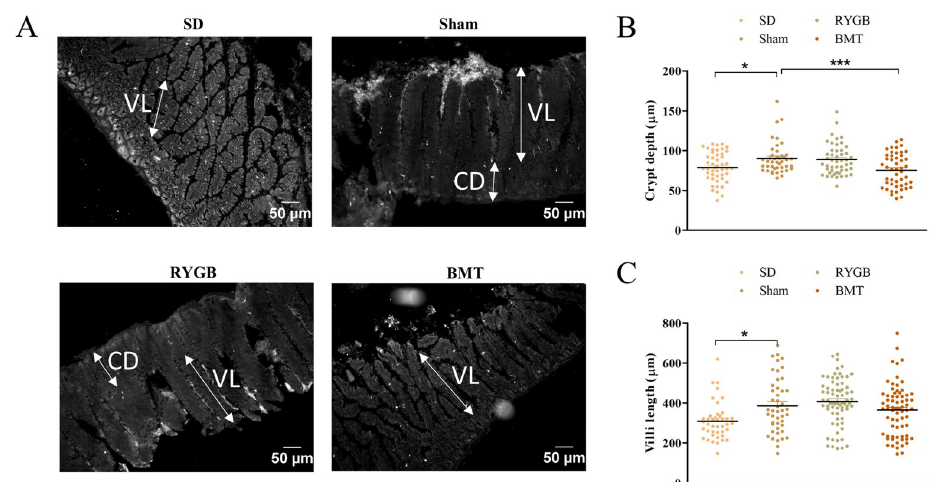
Fig 2. Effects of RYGB, BMT and sham surgery on intestinal morphology in ileum of ZDSD rats 8 weeks post- intervention. (A) Representative images showing cross-section of the ileum; arrows indicate villi length (VL) and crypt depth (CD). Quantification of morphological changes in (B) crypt depth and (C) villi length are shown. Normal SD rats are included for comparison. Values are mean ± SEM (n = 4) with statistical significance evaluated using one-way ANOVA. � p < 0.05, ��� p < 0.001 compared to sham rats.